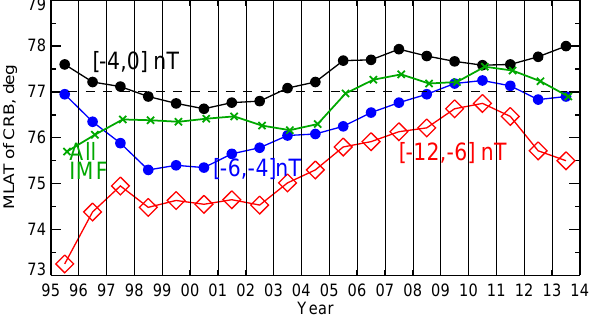
Figure 5. Magnetic latitude of the convection reversal boundary (CRB) location on the dusk side (yearly medians for data between 17:00 and 19:00MLT) for 19years of consecutive SuperDARN ob- servations. Presented CRBs are for IMF B z < 0 and three bins of the B − t magnitude: [ − 4,0]nT (black dots), [ − 6, − 4]nT (blue dots), and [ − 12, − 6]nT (red diamonds). Green crosses connected by solid green line are typical CRB locations for a case of all SuperDARN data considered irrespective of the